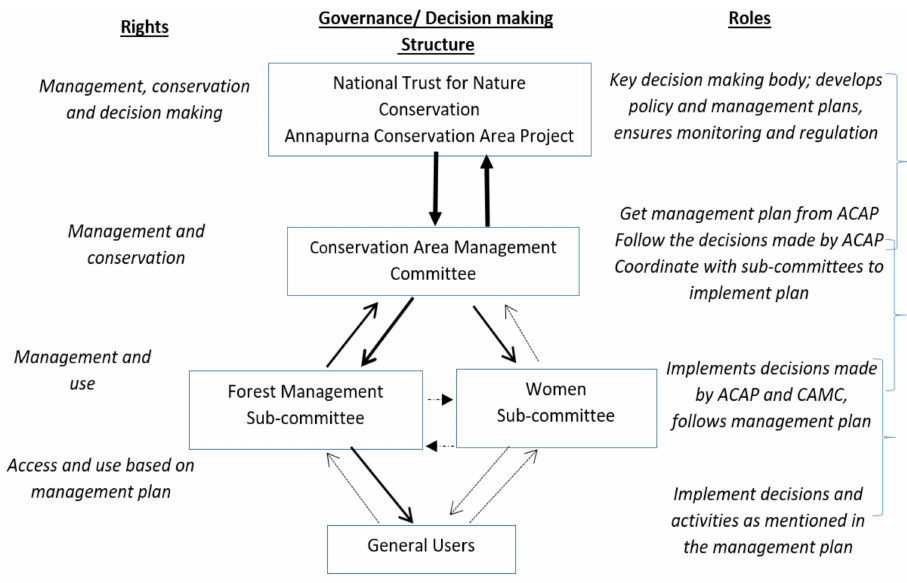
Figure 3. Governance / decision making structure, roles, and rights of co-management actors in ACAP. Note: Bold arrow represents strong decision-making role; the strength decreases as the thickness of arrow decreases. The decision making flow is grouped into three segments a, b, and c as explained